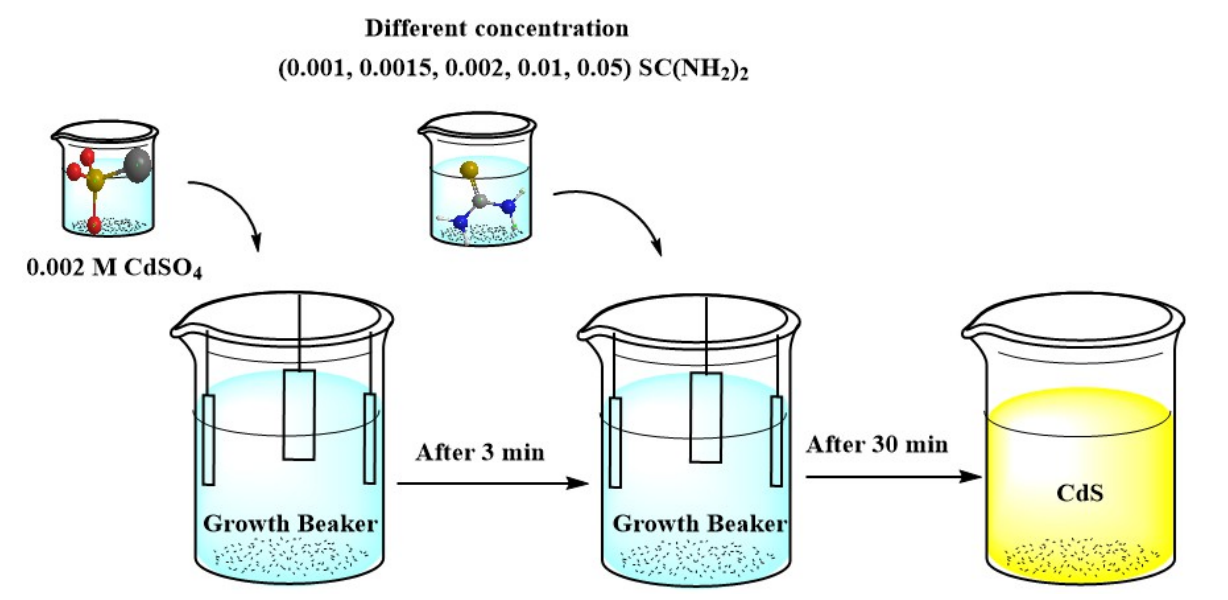
Figure 1. Synthesis CdS thin film by CBD technique.